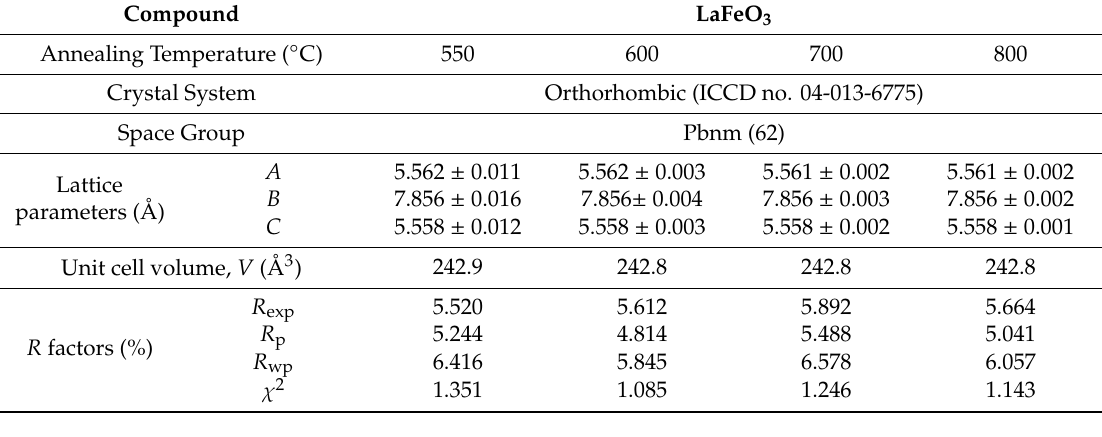
Figure 3. (a) Room-temperature XRD patterns and (b)–(e) results of Rietveld analysis of XRD data for